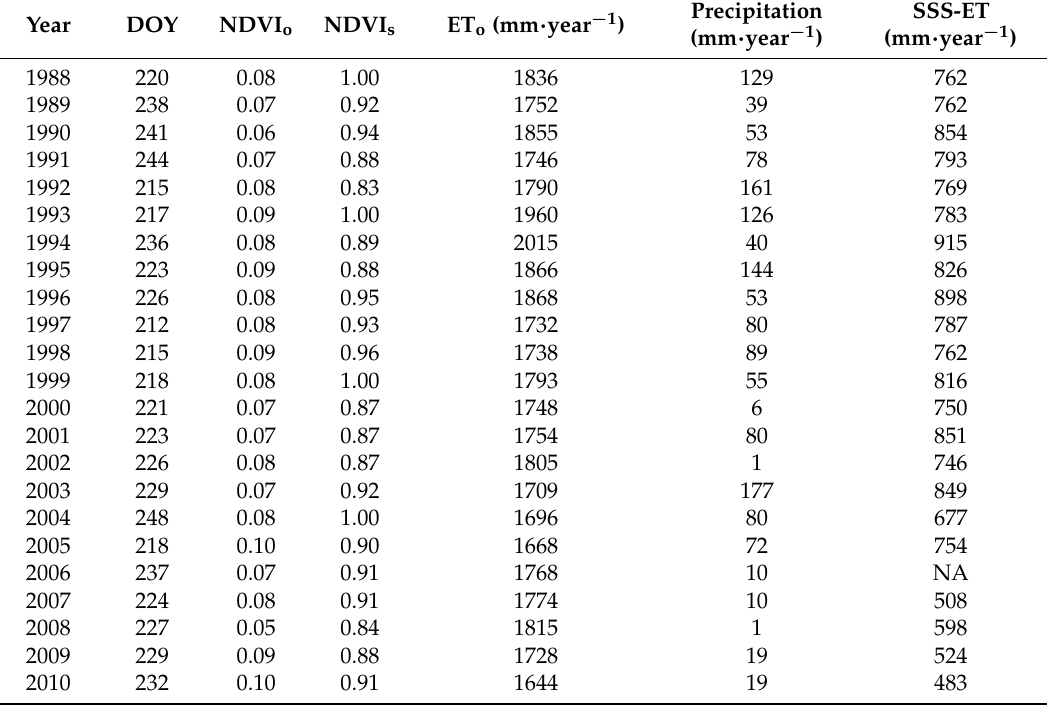
Table 2. Day of year (DOY) of selected Landsat images, their respective NDVI o and NDVI s , reference ET (ET o ), precipitation, and estimated annual SSS-ET for 23 years of